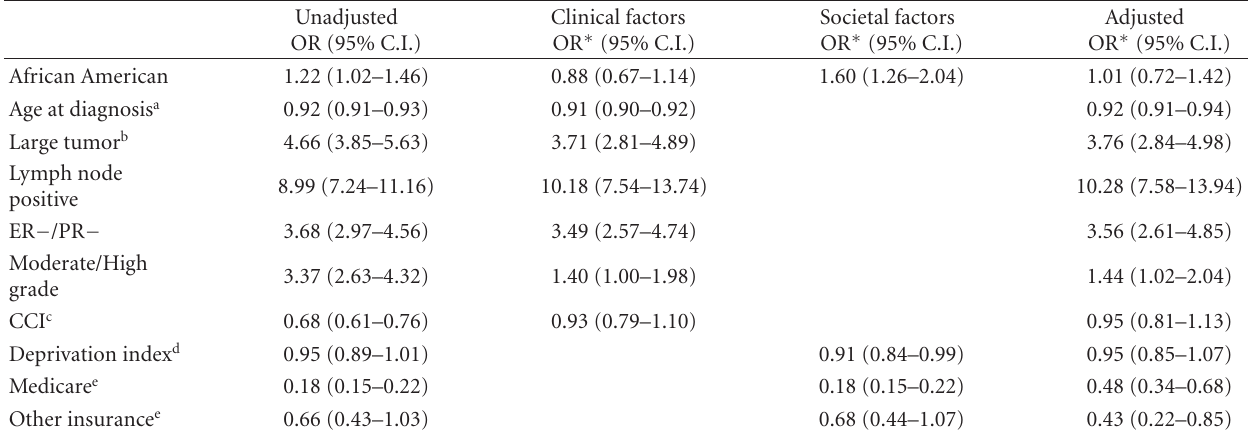
Table 3: Logistic regression analysis of predictors of the receipt of adjuvant chemotherapy. Unadjusted Clinical factors OR (95% C.I.)